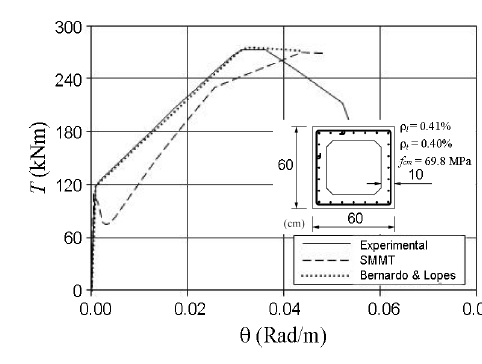
Fig. 16. T – θ curves for Beam C2